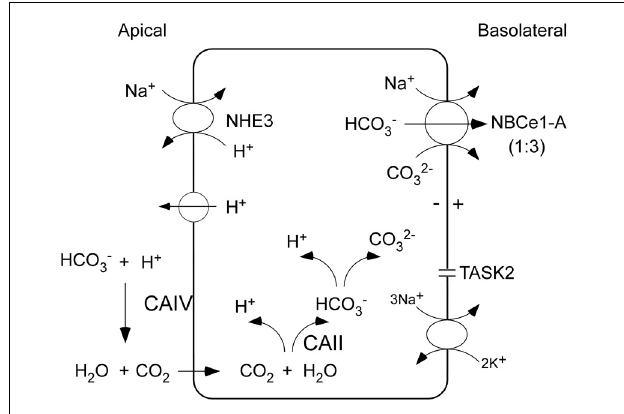
FIGURE 1 | Coupled apical and basolateral H + /base transport in proximal tubule cells mediates trancellular transport of bicarbonate. The charge transport stoichiometry of NBCe1-A in the human proximal tubule is unknown and is depicted as 1:3. Luminal bicarbonate is initially protonated via NHE3 (and to a lesser extent an apical V-ATPase) and is converted to CO 2 via a dehydration reaction that is accelerated by GPI anchored CAIV. Dissolved CO 2 permeates the apical membrane passively through the lipid bilayer (or possibly through AQP1) down its concentration gradient into the cell. In the cytoplasm, the reverse hydration reaction catalyzed by cytoplasmic CAII converts CO 2 to HCO − 3 which is in equilibrium with CO 2 − 3 . The basolateral Na + -K + -ATPase coupled with TASK2 K + channels generate the basolateral membrane potential, creating an electrical driving force for NBCe1-A mediated electrogenic Na + -base